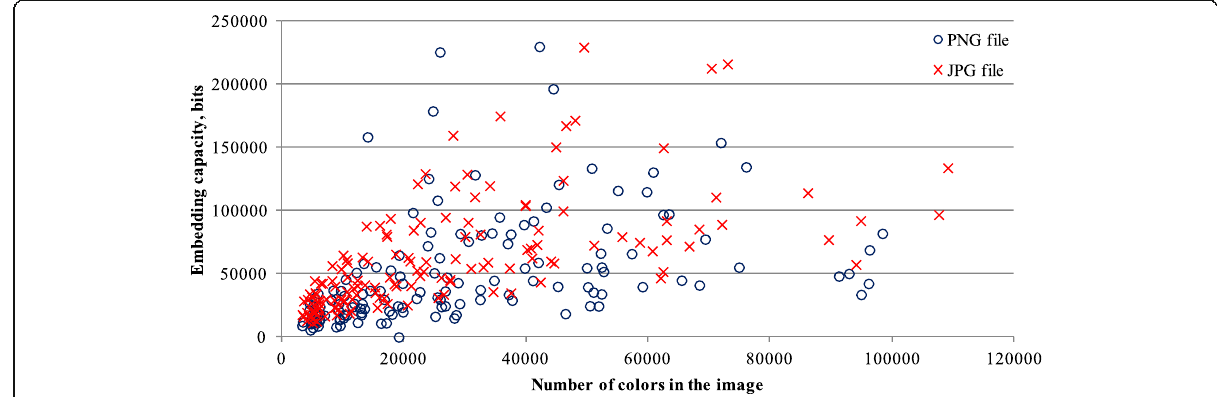
Fig. 6 Stegomessage embedding capability (bits) dependency on file format and number of colors in the